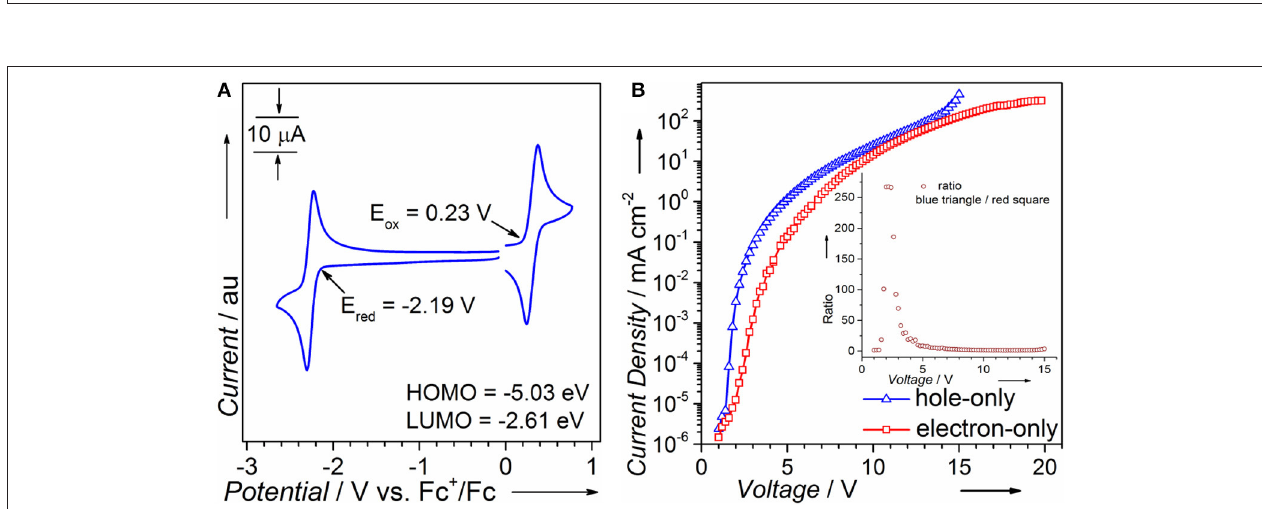
FIGURE 1 | (A) Cyclic voltammetry and (B) single carrier device of PTZMes 2 B.